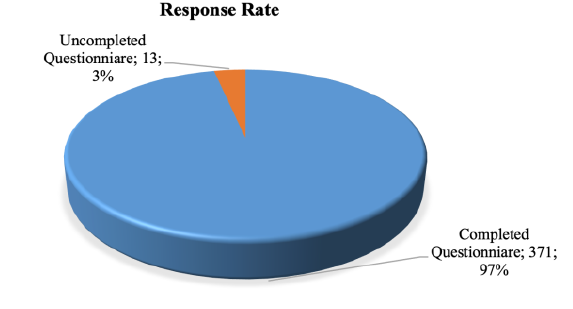
Figure 1 : Rate of Response; Source: Survey Data